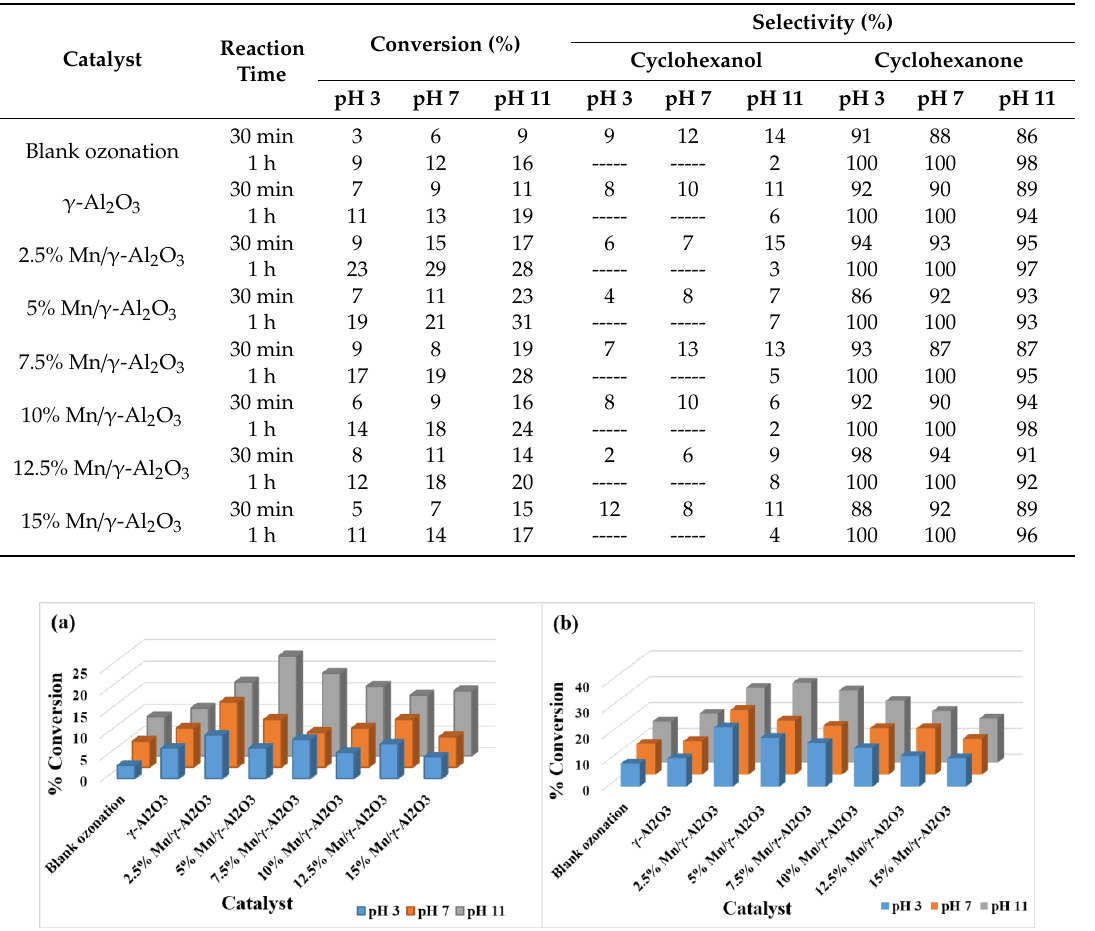
Figure 7. Percentage conversion profiles of cyclohexane vs. catalysts after ( a ) 30 min and ( b ) 1 h of ozonation time at 20 ± 1 °C and 1 atm. Table 3. Cyclohexane percentage conversion and selectivity toward KA oil at 20 ± 1 °C and 1 atm.